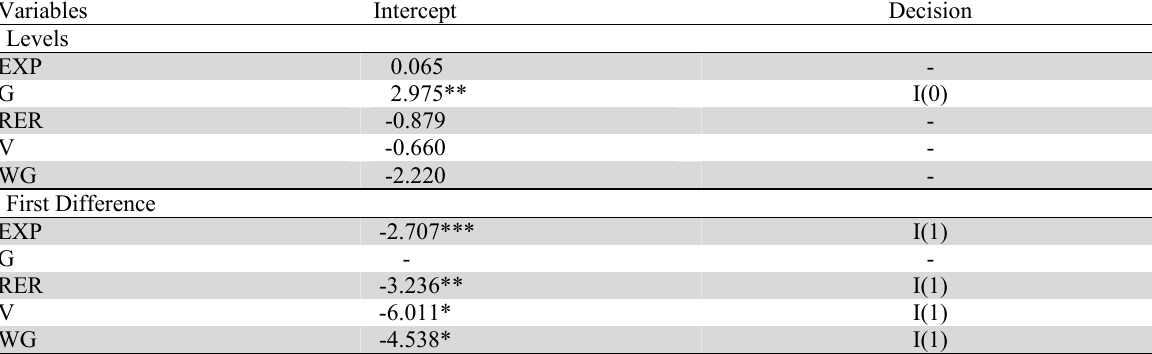
Augmented Dickey-Fuller Test